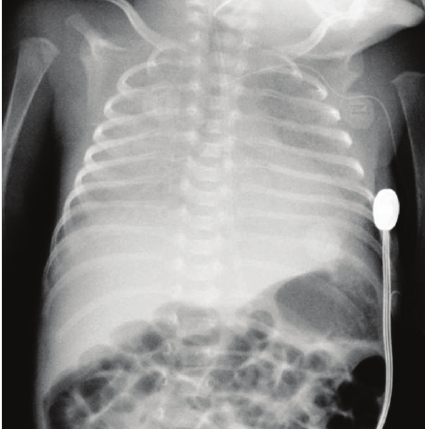
Figure2:Chestradiograph(20daysoflife)showingbilateraldiffuse alveolar